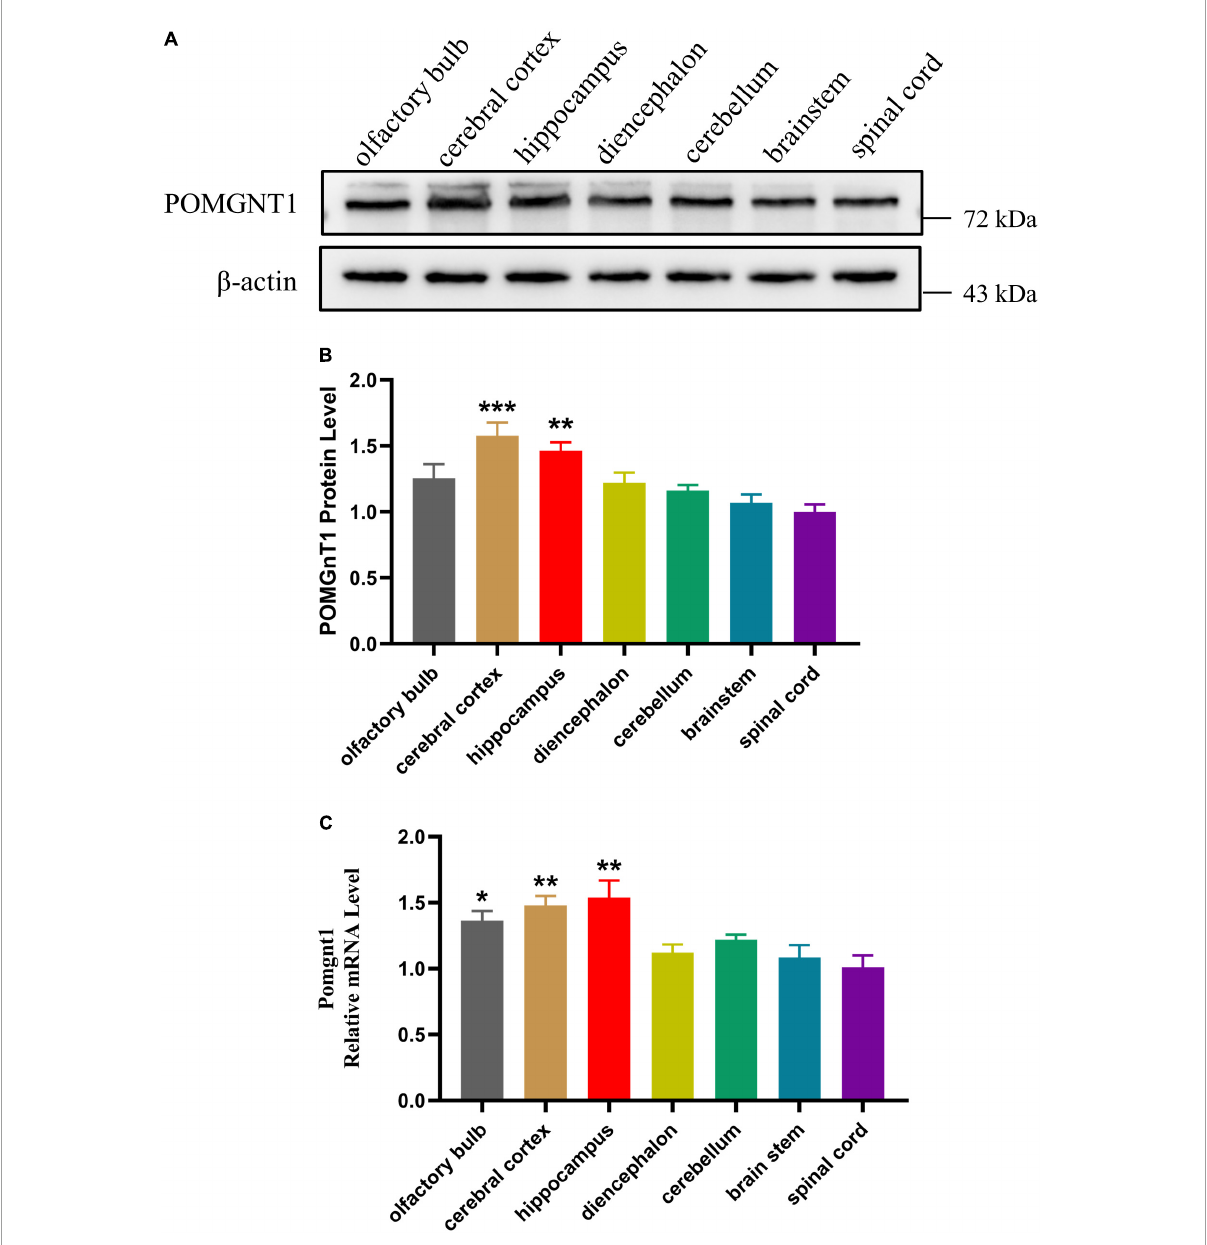
FIGURE1 Expression of POMGNT1 in various regions of mouse brain. (A) Western blot was reprobed with mouse anti- β -actin antibody as the loading control. In total, 50 µ g of protein was separated by SDS-PAGE transferred to a membrane, and probed with anti-POMGNT1 and anti- β -actin antibodies. (B) Quantifications showing the different protein expression levels of POMGNT1 in different brain regions. (C) RT-qPCR to measure the expression level of Pomgnt1 in different regions of the brain and spinal cord. Data are presented as the mean ± SEM; * P < 0.05; ** P < 0.01; *** P < 0.001 versus the spinal cord group (one-way ANOVA). N =